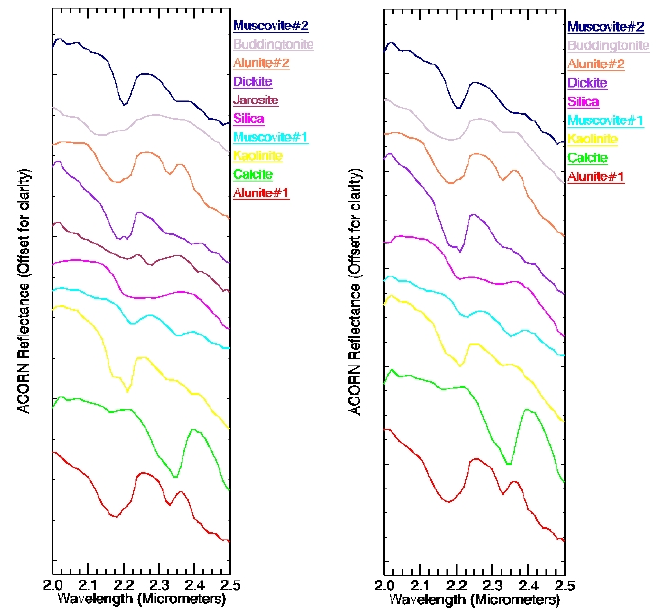
Figure 1. Left: SWIR endmembers for the full Cuprite-Goldfield HyspIRI 15 m simulated dataset. Right: SWIR endmembers for the full Cuprite-Goldfield dataset at HyspIRI 60 m spatial resolution. There are some small differences between the endmember spectra caused by spectral mixing at the 60 m resolution. Most apparent of these in the 60 m resolution data are (1) a shift of the main feature for “buddingtonite” towards 2.16 μ m caused by mixing with alunite; (2) shallowing of the 2.16 μ m band for “dickite” to appear more similar to kaolinite; (3) disappearance of the jarosite endmember at 60 m resolution; (4) contamination of the broad 2.25 silica feature with other smaller features near 2.3 μ m; and (5) loss of sharpness of the kaolinite doublet at 2.16 and 2.2 μ